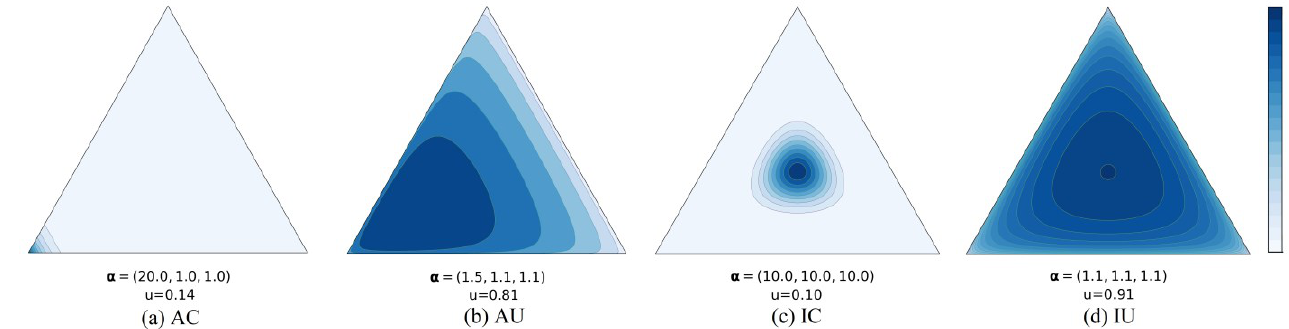
Figure 3. Examples of the Dirichlet distribution (triple classification is taken as an example, where the sample label is the first category). The Dirichlet distribution is different when the predictions of model are ( a ) accurate and certain (AC), ( b ) accurate and uncertain (AU), ( c ) inaccurate and certain (IC), ( d ) inaccurate and uncertain (IU).